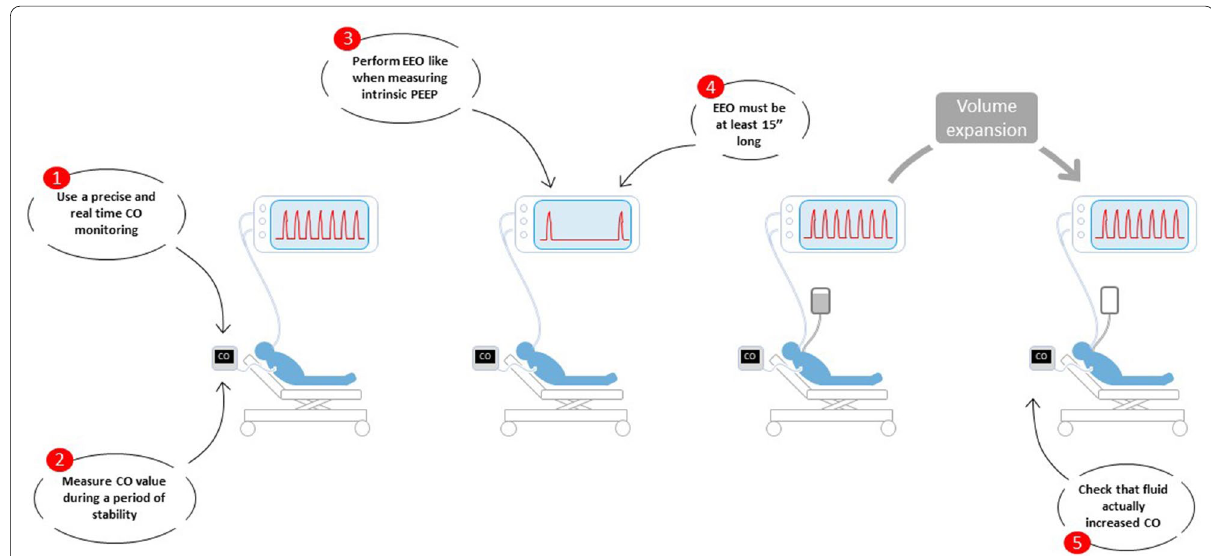
Fig. 2 Practical rules for performing an end‑expiratory occlusion test. CO cardiac output, EEO end‑expiratory occlusion test, PEEP positive end‑expiratory